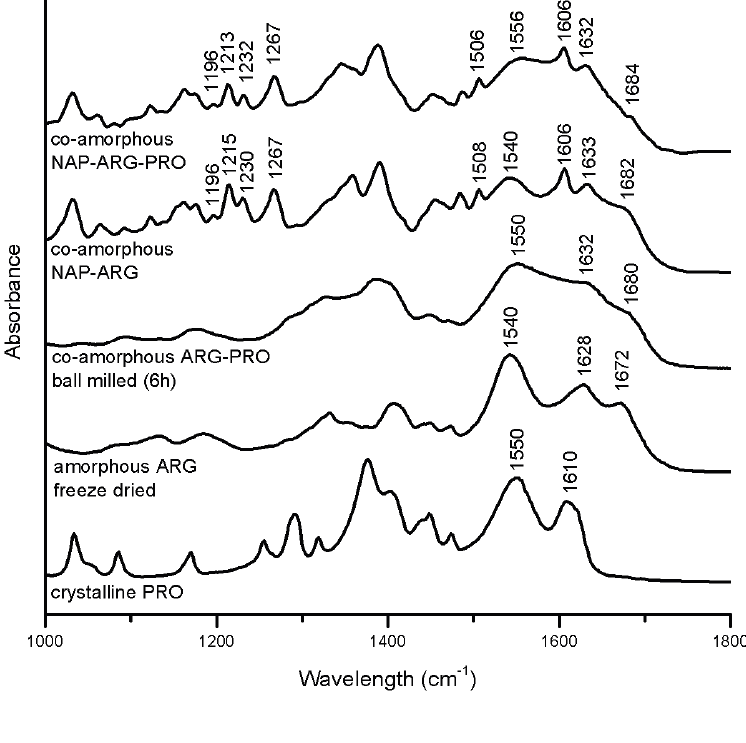
Figure 7. FTIR spectra of crystalline PRO, as well as the spectra of amorphous freeze-dried ARG, co-amorphous ARG–PRO ball milled for 6 h, co-amorphous NAP–ARG and co-amorphous